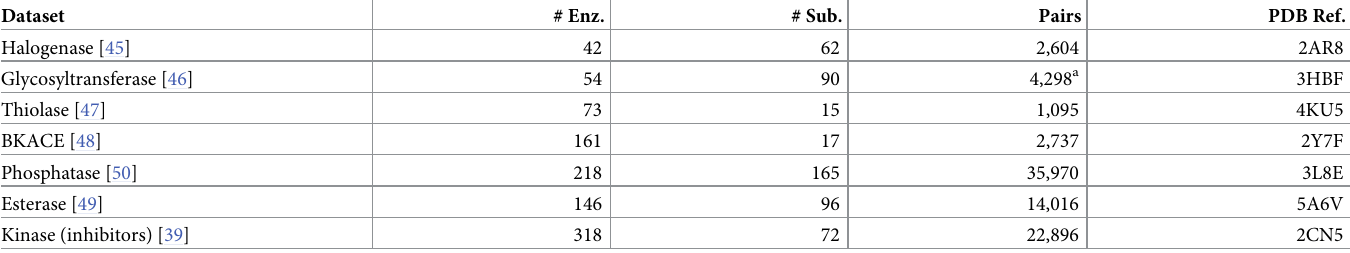
Table 1. Summary of curated datasets with the number of unique enzymes, unique substrates, and unique pairs in each dataset in addition to an exemplar structure for the protein family. Dataset # Enz. # Sub. Pairs PDB